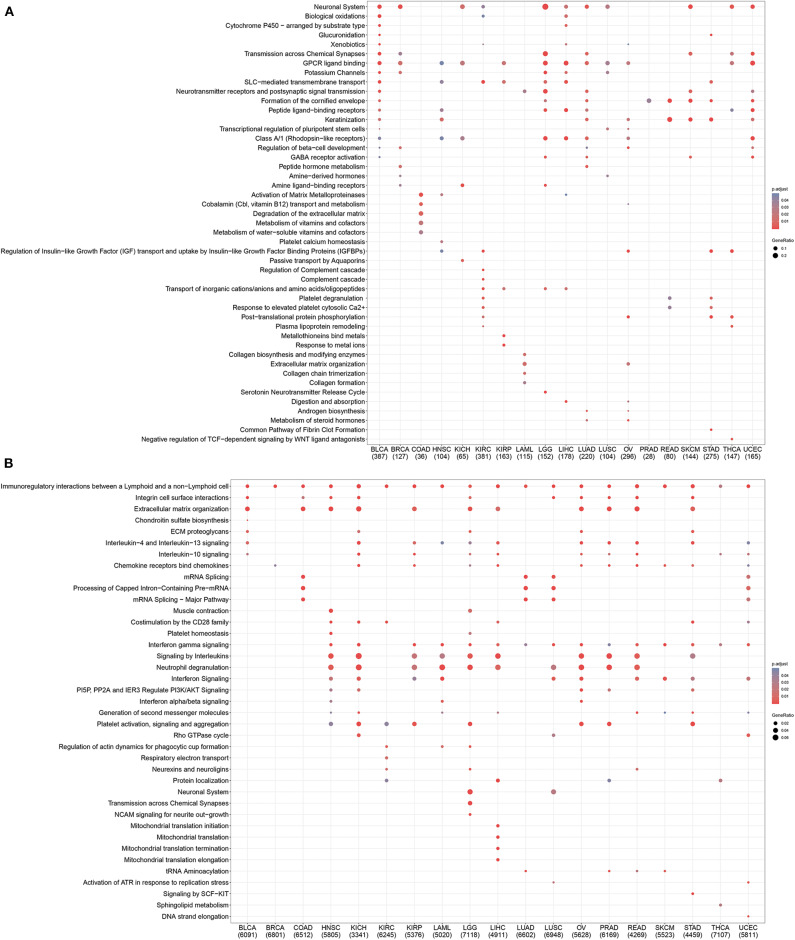
Pan-cancer gene functional annotation of TME phenotype associated genes. (A) Gene function of upregulated genes in non-inflamed TME. (B) The function of inflamed TME associated genes. The number under abbreviation represents the number of differently expressed genes (DEGs).